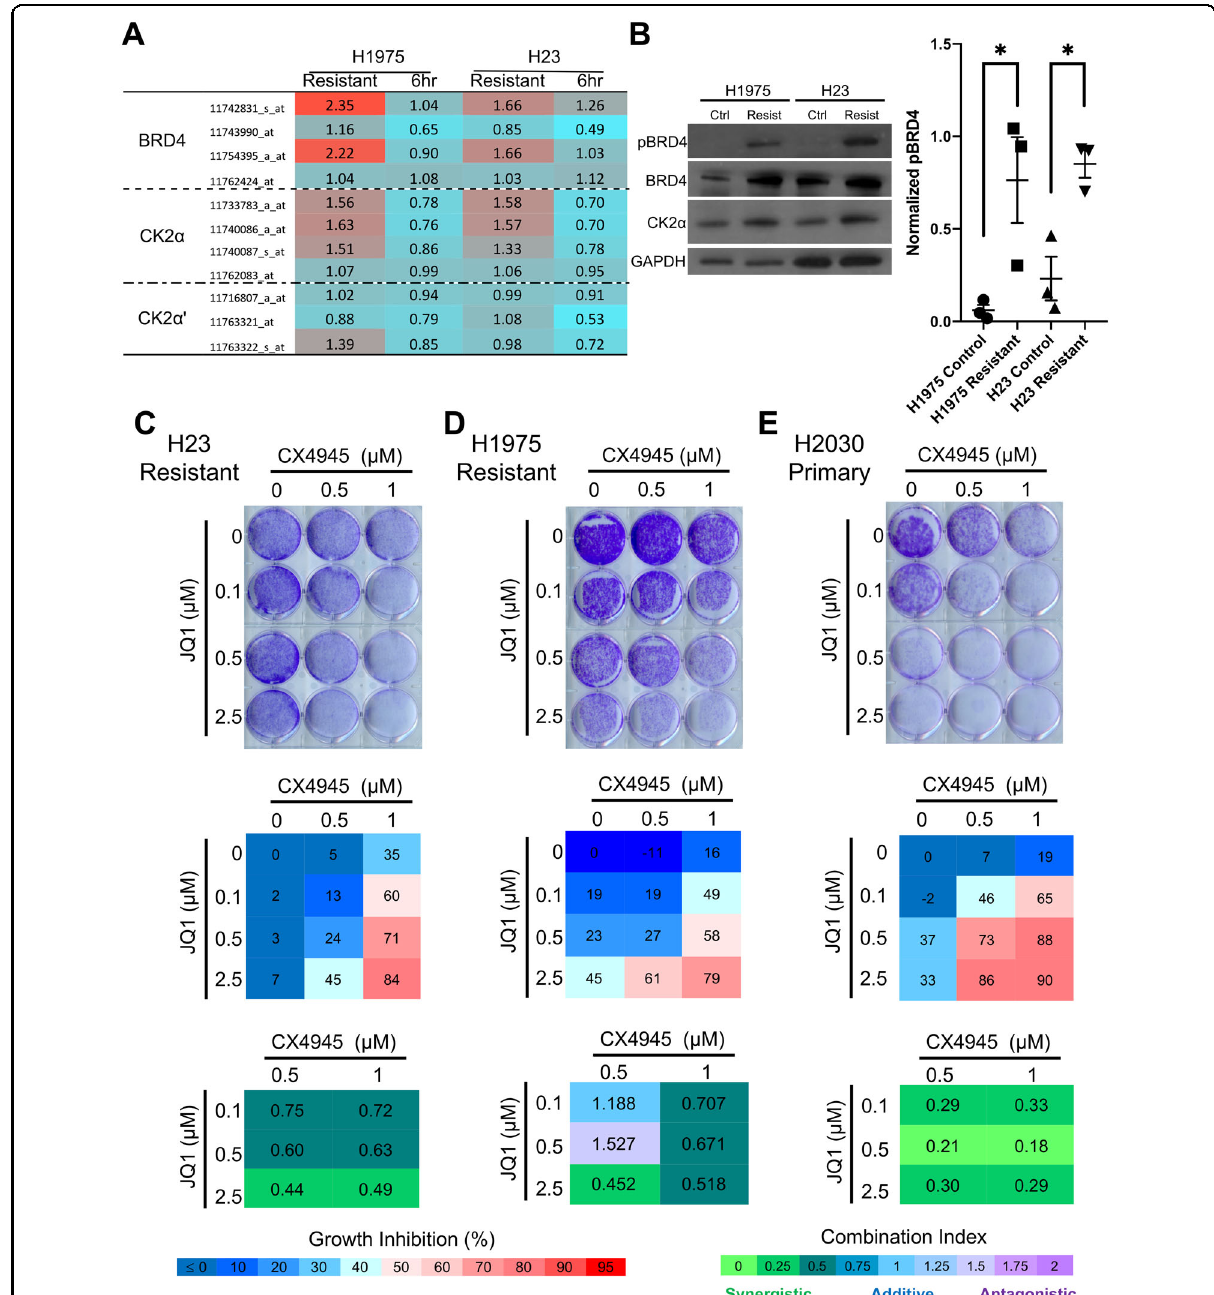
Fig. 5 Phosphorylated BRD4 and the kinase CK2 are elevated in JQ1 resistant lines and are synergistic in inducing cell death when inhibited. A mRNA expression analysis shows increased expression of BRD4 and CK2 α levels for resistant lines, but no change in CK2 α ′ levels. Values represent fold changes as compared to the control line for each speci fi c cell line and condition. 11742831_s_at and 11754395_a_at are probes speci fi c for the long isoform of BRD4. Color scale represents lower (blue) or higher (red) degree of expression compared to control. B Western blot analysis of pBRD4 and BRD4 levels, speci fi c to the long isoform, as well as CK2 α levels in JQ1 resistant and their control counterparts. Densitometry data for relative pBRD4 levels are plotted in scatter format for three independent western blots from independent cell lysates. GAPDH serves as a loading control and bars represent SEM (* P < 0.05, two-tailed, unpaired T test). C – E Combination growth assays for H23 ( C ) and H1975 ( D ) acquired resistant lines, and H2020 ( E ) primary resistant LAC cell line treated with the indicated combinations of JQ1 and CX-4945 for 10 days. Crystal violet images are representative of triplicate biological experiments. Cell viability was measured at the endpoint using Alamar Blue and the percent inhibition calculated compared to the no drug control, with the mean value of three biological replicates indicated. CompuSyn was used to calculate combination index (CI) scores for each drug combination with <0.75 indicating synergy, 0.75 – 1.25 indicating additive effects, and >1.25 indicating antagonism. Legends for percent growth inhibition and combination index values are shown at the